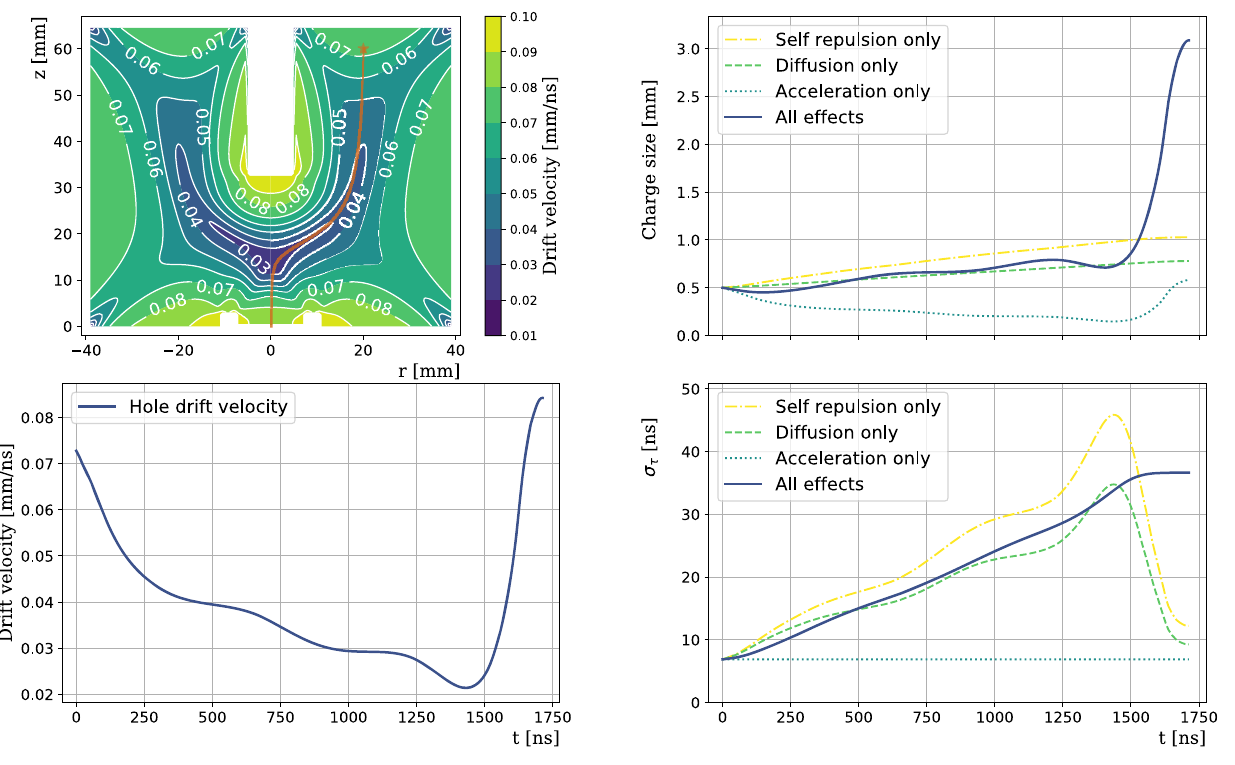
is shown in the bottom-left plot. The evolution of the cluster’s size and σ τ is displayed in the top-right and bottom-right plot, respectively. The initial size of the cluster is 0.5 mm, the average for energy depositions of 1.6